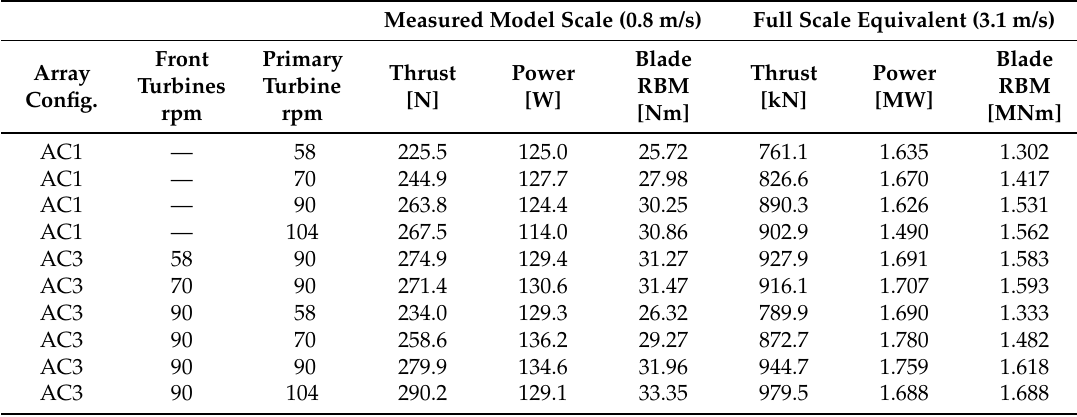
Table 3. Thrust and power of the turbine plus root bending moment of a blade for selected rotational speeds. Values given for model scale and full scale